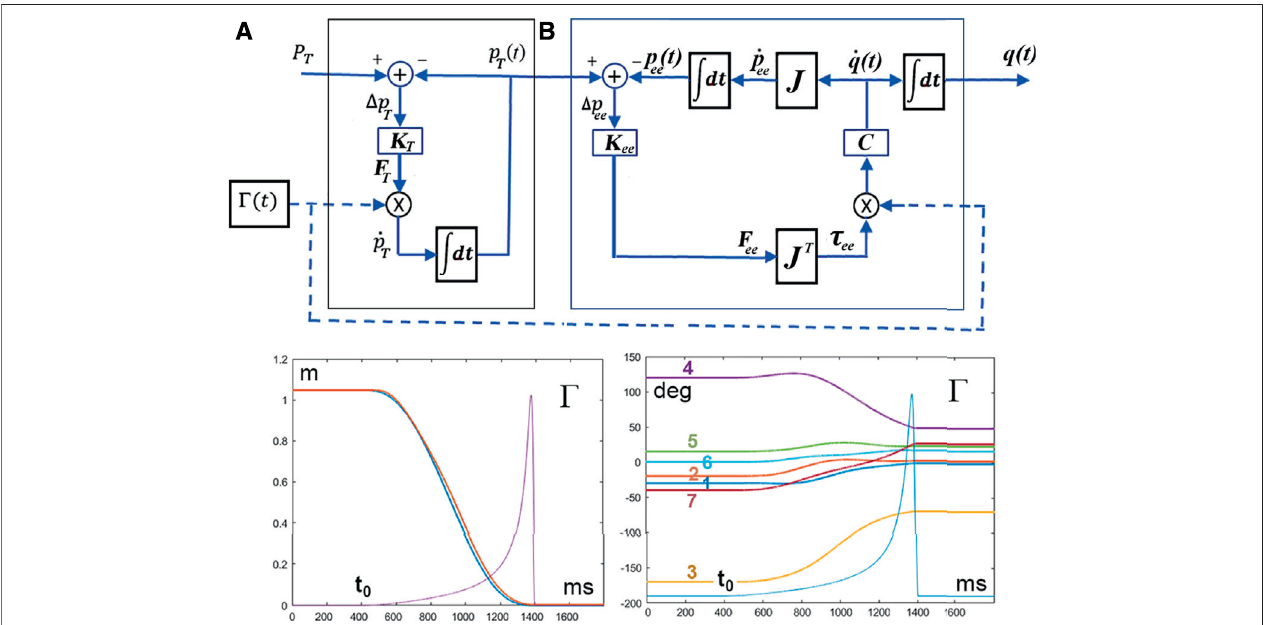
FIGURE 4 | (A) : Extended PMP model for solving the Degree of Freedom problem; the module A generates the moving target _ p T ( t ) , attracted to the fi nal target pointbytheforce fi eld F T ;themodule (B) generatesthetrajectoryoftheend-effector ( p ee ( t )) anddistributestheactiontoalltheDoFs ( q ( t )) byusingtheforce fi eld F ee . In the lower part of the fi gure the left graph shows the time course of the distance from the fi nal target point of the moving target (red curve) and of the end-effector (blue curve); the right graph shows the time course ofthe 7 DoFs (yaw-pitch-rollof the wrist, pitch of the elbow, and yaw-pitch-roll of the wrist); both graphs also include the common Γ